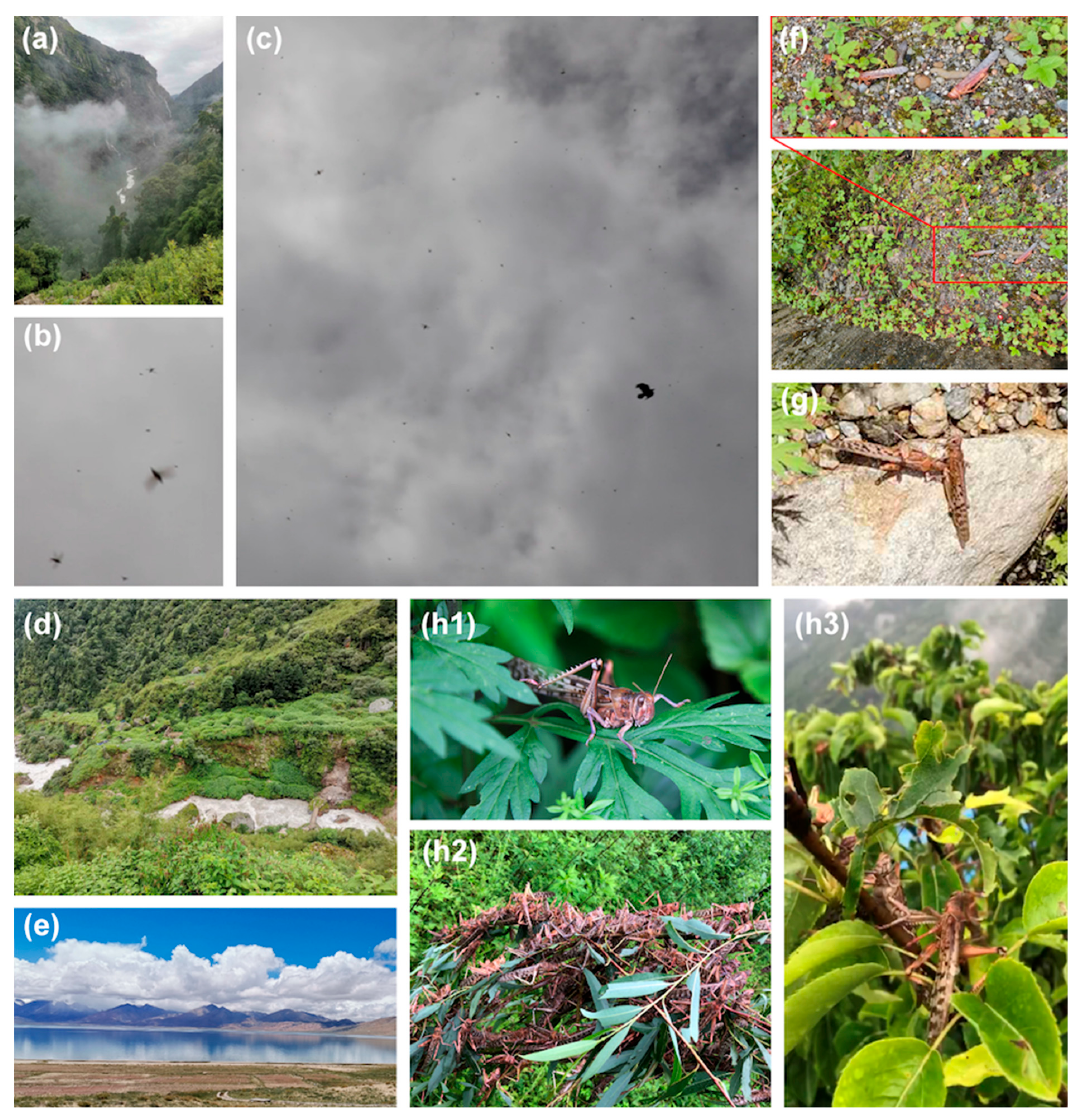
Figure 2. Some views of desert locusts in southern Tibet, in 2020, not far from the border with Nepal. ( a ) A valley having been invaded. ( b , c ) Light swarms of locusts flying in the clouds at about 3000 m. ( d ) The Boqu River valley at 3360 m. ( e ) Landscape at 4670 m altitude with lakes, sandy beaches, and a rare vegetation. ( f ) Desert locusts found dead in the field at an altitude of 3350 m. ( g ) basking in the sun on stones, or ( h1 – h3 ) feeding on wormwood and willow leaves.